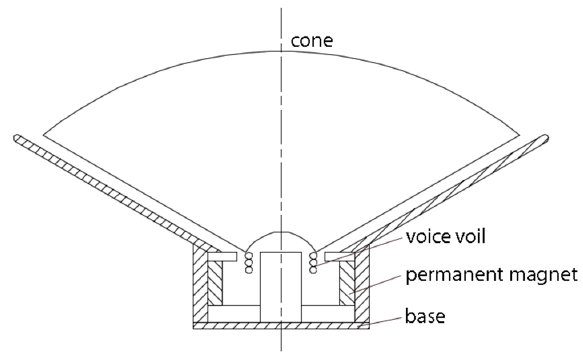
Figure 3. Drawing with the cone speaker’s main parts.